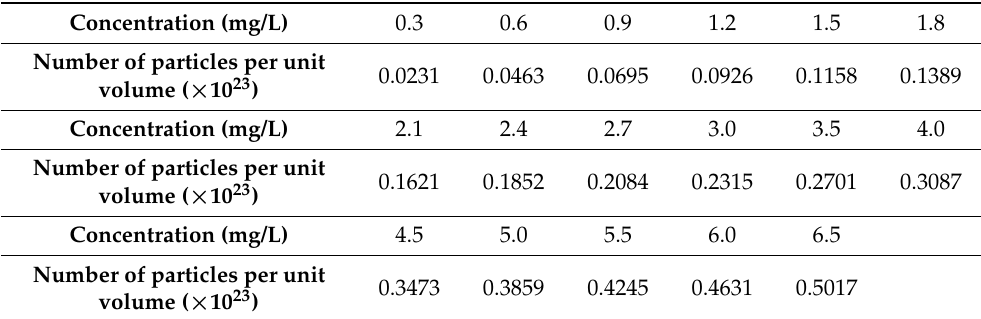
Table 1. The number of particles per unit volume in the simulation for seawater containing different concentrations of the suspended matter used in the experiment.